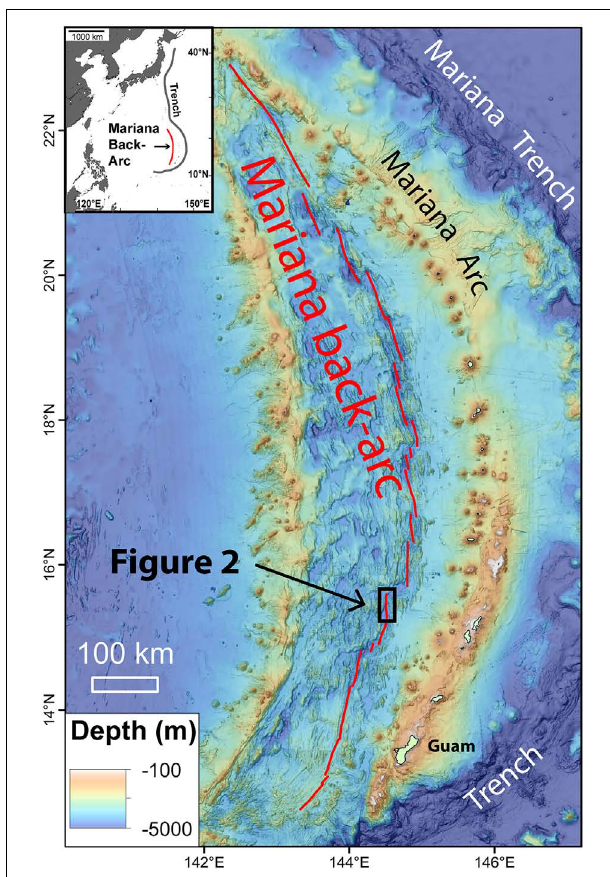
FIGURE 1 | Regional map showing location of the study area on the 15.5 ◦ N segment of the Mariana back-arc. Black box shows area of Figure 2 . Inset map shows the location of the Mariana back-arc relative to the western Pacific trenches, with Japan to the north and the Philippines to the west.